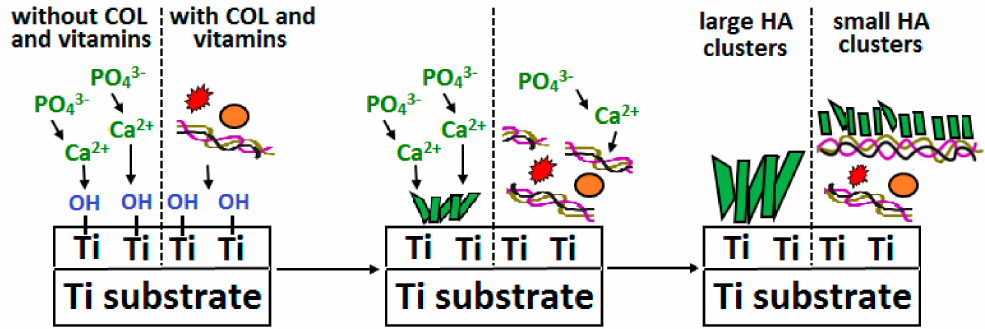
Figure 5. Comparison of the formation of various CaP aggregates and clusters on a Ti surface without and with modification via COL and vitamins as templates, according to Ciobanu and Ciobanu